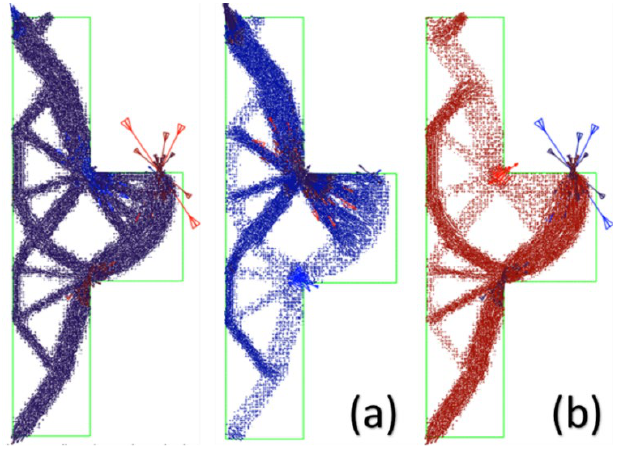
Figure 8. Principal stress trajectories for f = 50% (a: tension; b: